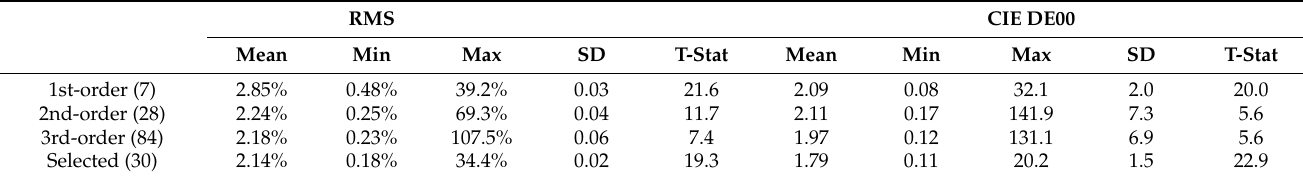
Table 2. Performance of reflectance estimation using two illuminants with different polynomial ex-